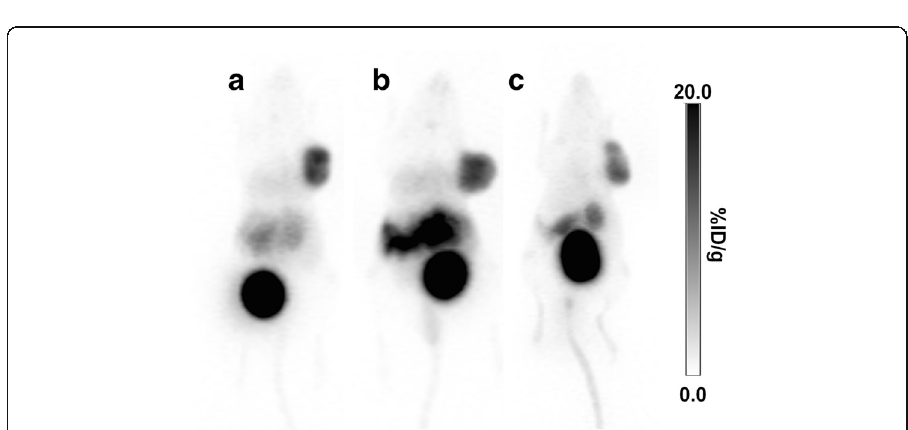
Fig. 4 PET maximum intensity projection images of a . 68 Ga-DOTATOC, b . 68 Ga-DOTATATE and c . 68 Ga- NODAGA-JR11 in ZR-75-1 tumor bearing